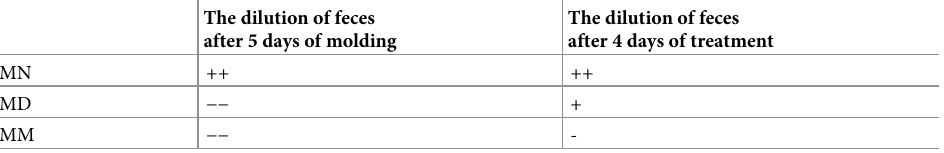
Table 1. The influence of the clinical features of